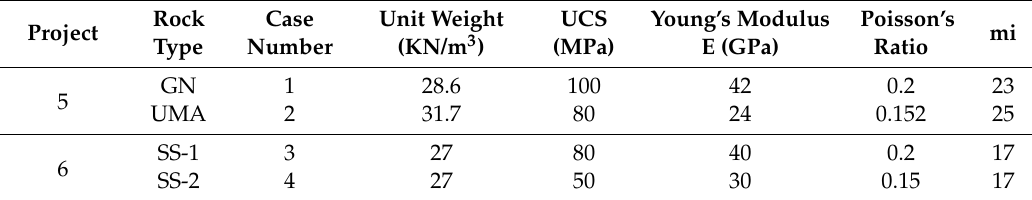
Table 9. Intact rock properties for different rock types of projects 5 and